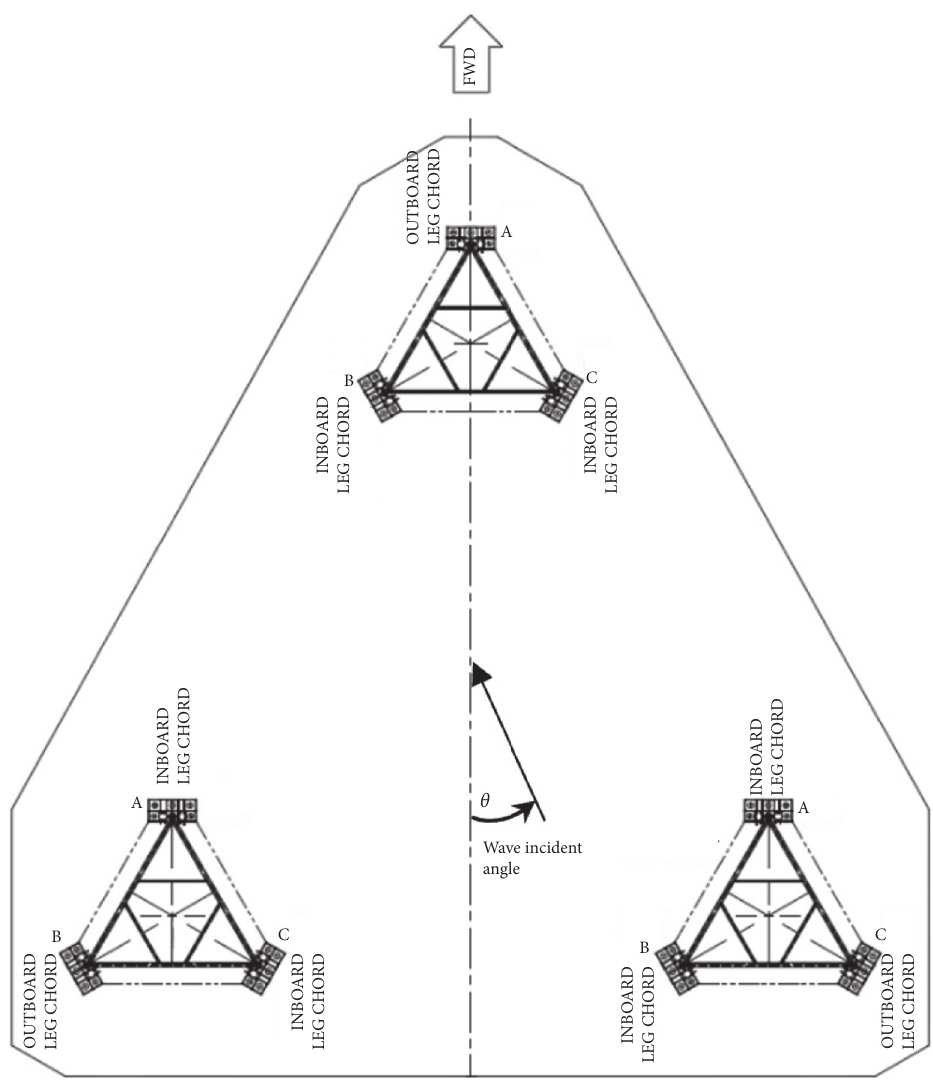
Figure 6: Schematic top view of the hull and leg structures with concerned